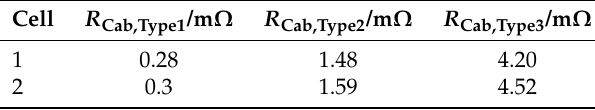
Table 2. Investigated cable